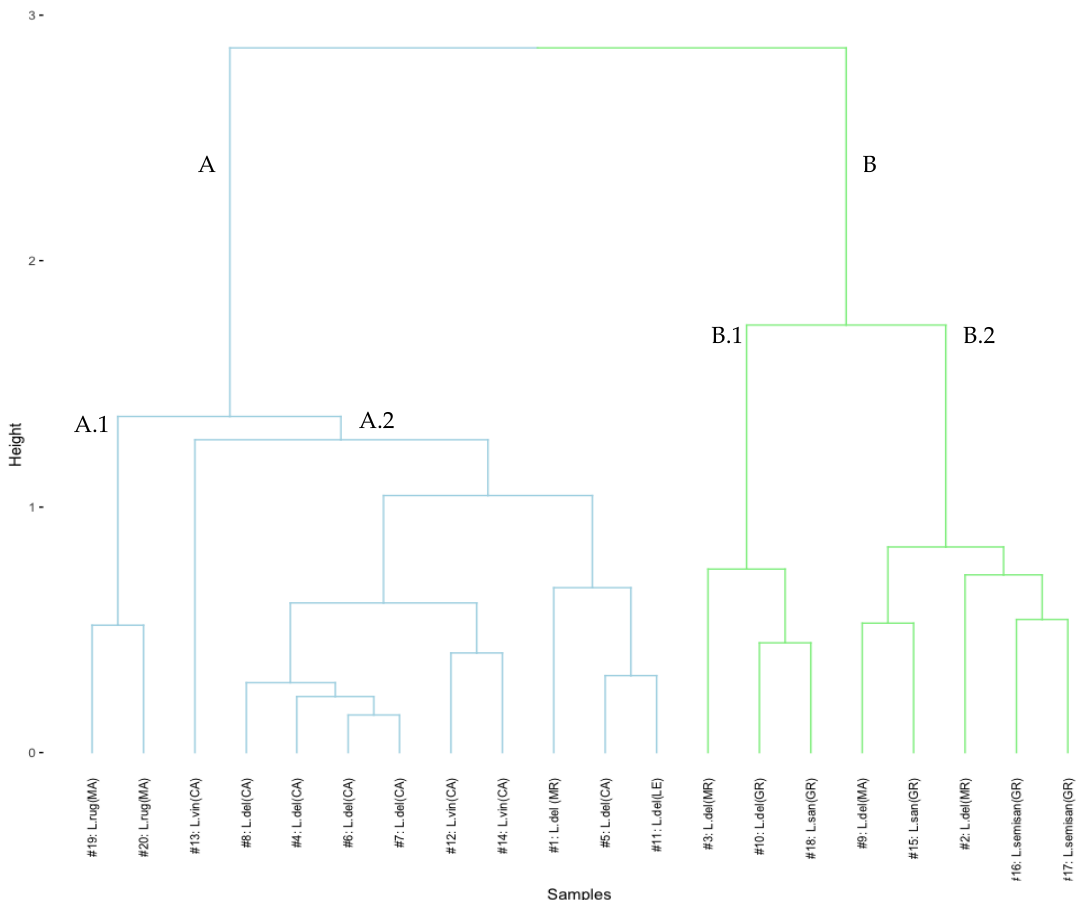
Figure 2. Graphical display of the resulting HCA dendrogram using Euclidean distance and Ward’s method to identify clustering trend patterns among the studied mushroom species based on the content of the seven macronutrients determined. Table 4. Daily intake of metals in samples of Lactarius mushrooms analyzed and recommended daily intake.